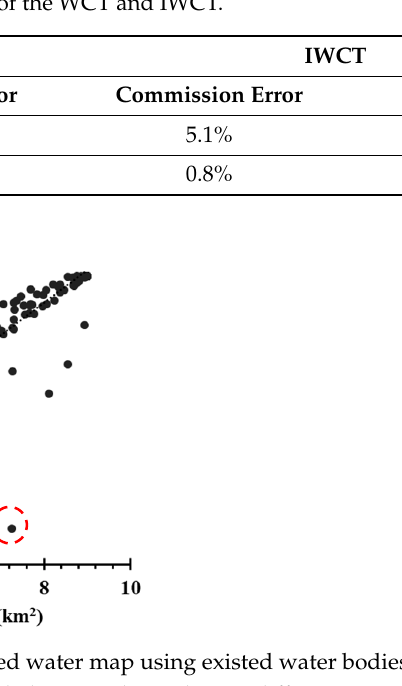
Table 1. Classification accuracy of the WCT and IWCT.